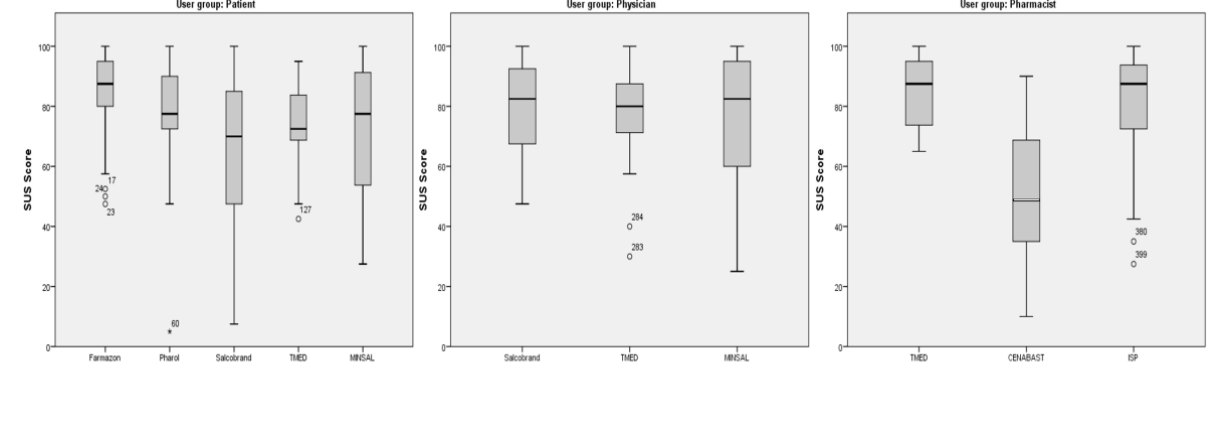
Figure 5. SUS box plots: the lower (Q1) and upper (Q3) quartile, representing observations outside the 9-91 percentile range. The diagram also shows the median observation. Data falling outside the Q1-Q3 range are plotted as outliers. CENABAST: National Health Service System of Chile; ISP: Public Health Institute of Chile; MINSAL: Ministry of Health of Chile; SUS: system usability scale; TMED: medication terminology.